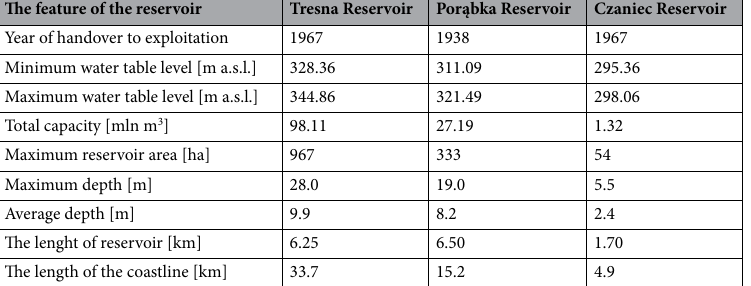
Table 1. Characteristics of reservoirs based on data in the monograph of the Soła River dam cascade 27